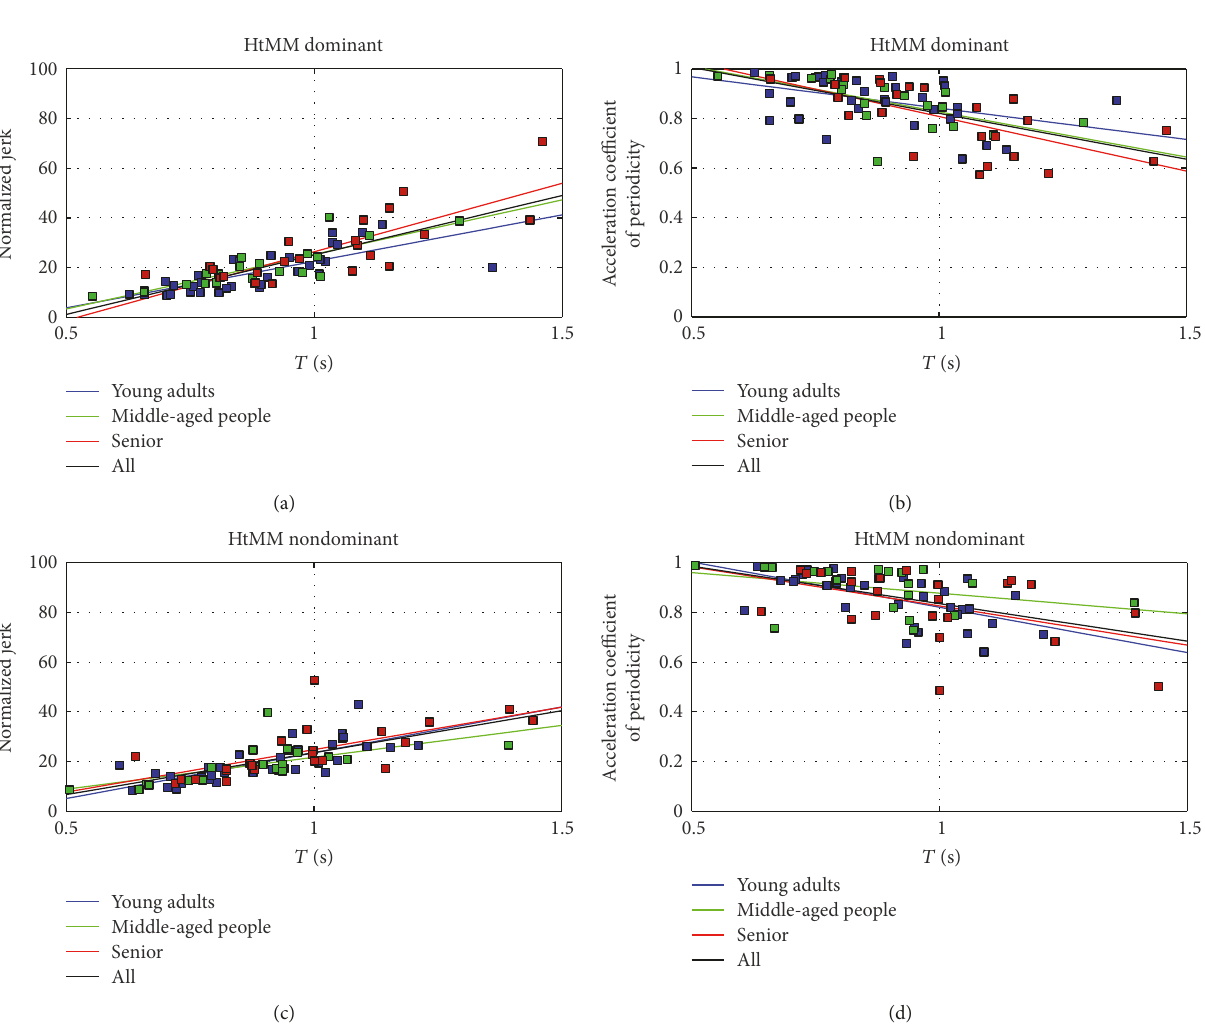
Figure 5: HtMM: regression curves for normalized jerk and acceleration coe ffi cient of periodicity for age